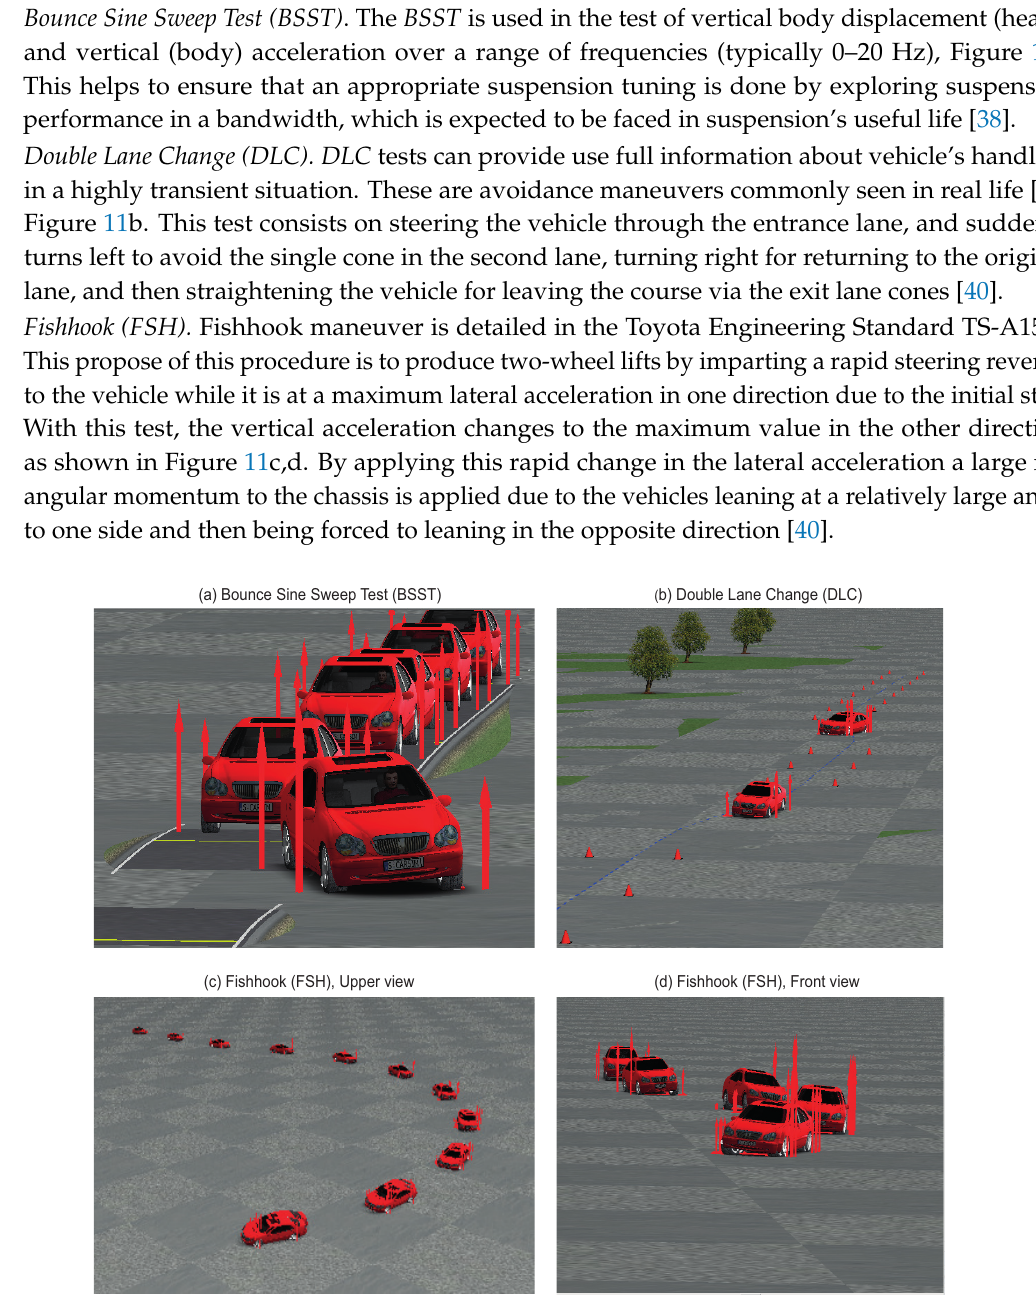
Figure 11. Implemented tests in CarSim for a full vehicle